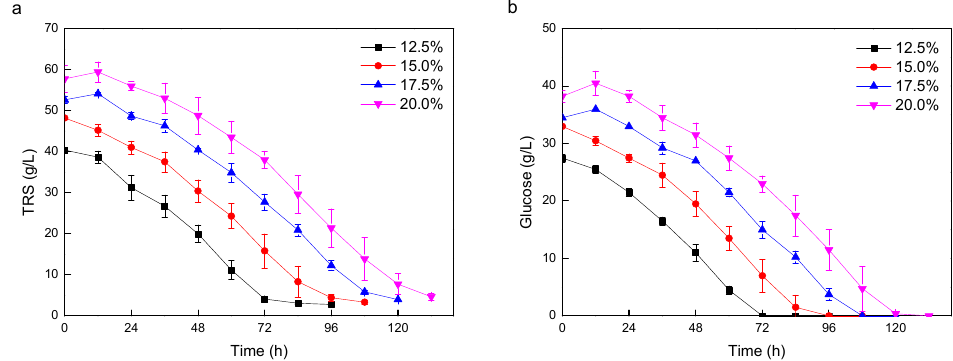
Figure 3. TRS ( a ) and glucose ( b ) evolution profiles of PreSSLP process with various solid loading.